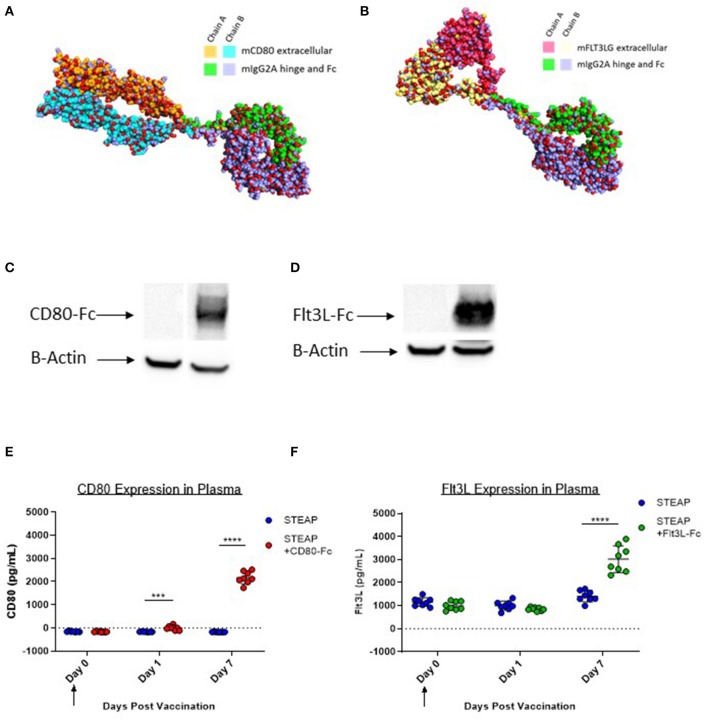
CD80-Fc and Flt3L-Fc express in vitro and in vivo. (A) Comparative model of murine Flt3L extracellular domain-murine IgG2A fusion. (B) Comparative model of murine CD80 extracellular domain-murine IgG2A fusion (C,D) 293T cells were transfected and Flt3L-Fc (C) and CD80-Fc (D) expression was analyzed by Western blot and compared to pVAX control. (E,F) Mice were immunized and Flt3L-Fc (E) and CD80-Fc (F) expression was measured in the plasma over time. N = 8 mice, ***p < 0.001, ****p < 0.0001.